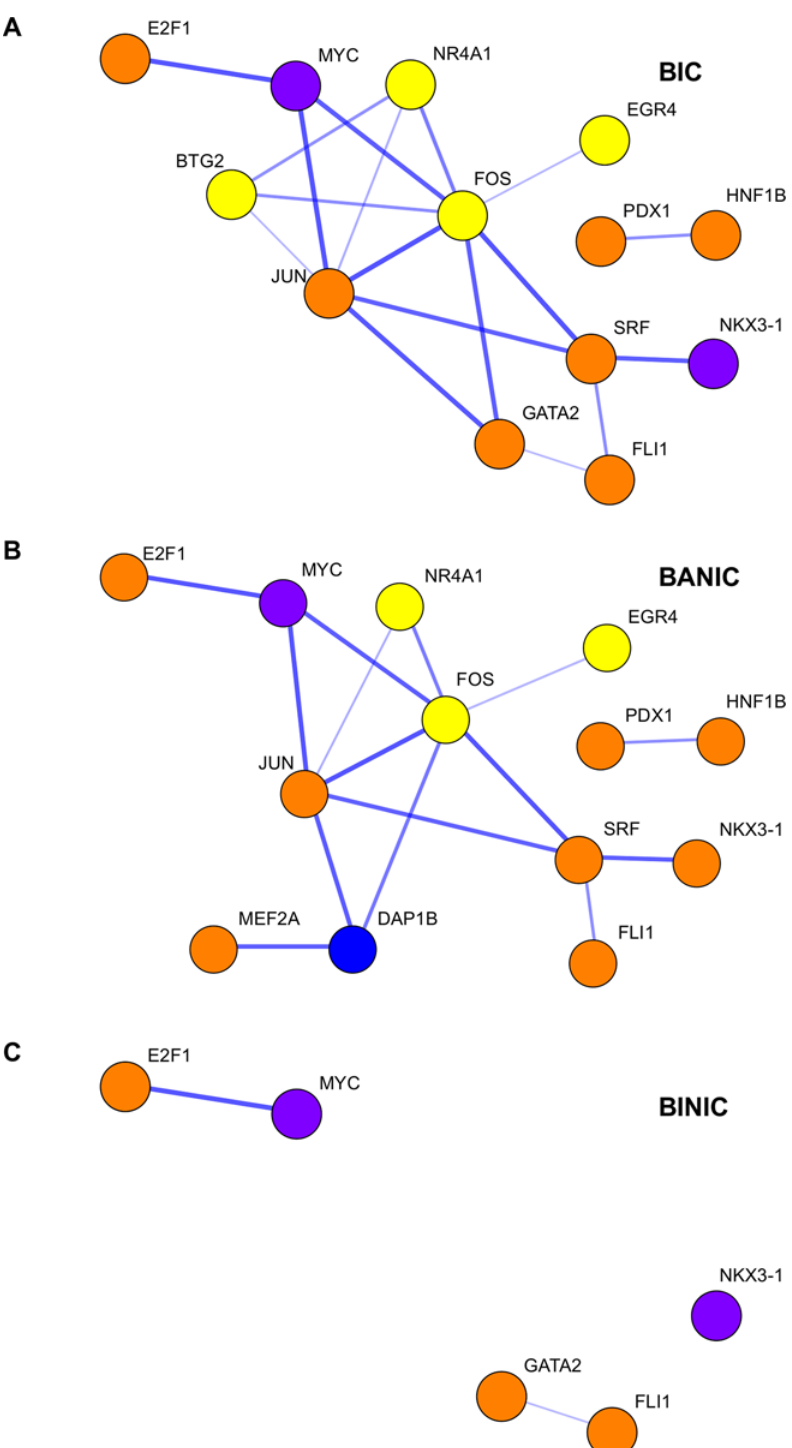
Fig 4. Transcription networks of the different behavioral groups. Networks consisting of DE genes and enriched transcription factors TF for the behavioral groups: (A) bystanders to interacting conspecifics (BIC); (B) bystanders attentive to non-interacting conspecifics (BANIC); and (C) bystanders inattentive to non- interacting conspecifics (BINIC). The thickness of the edges correspond to the confidence score of the genes ’ association, yellow nodes indicate up-regulated DE genes, blue nodes indicate down-regulated DE